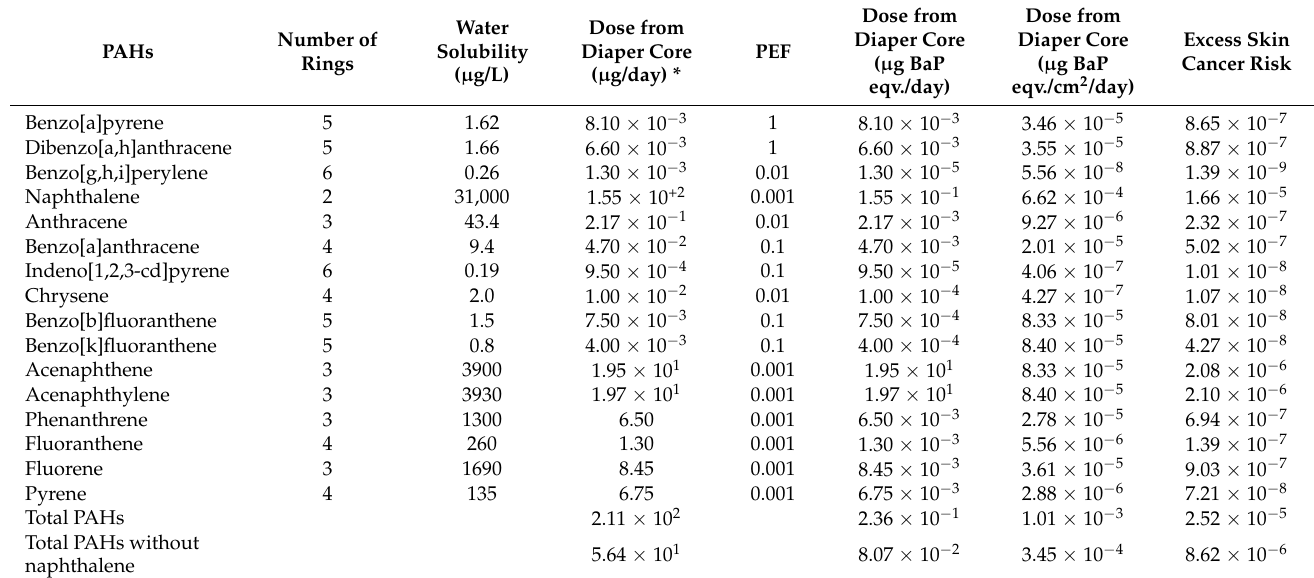
Table 3. Excess skin cancer risks of polycyclic aromatic hydrocarbons (PAHs) in the diaper core calculated with their respective limit of solubility in